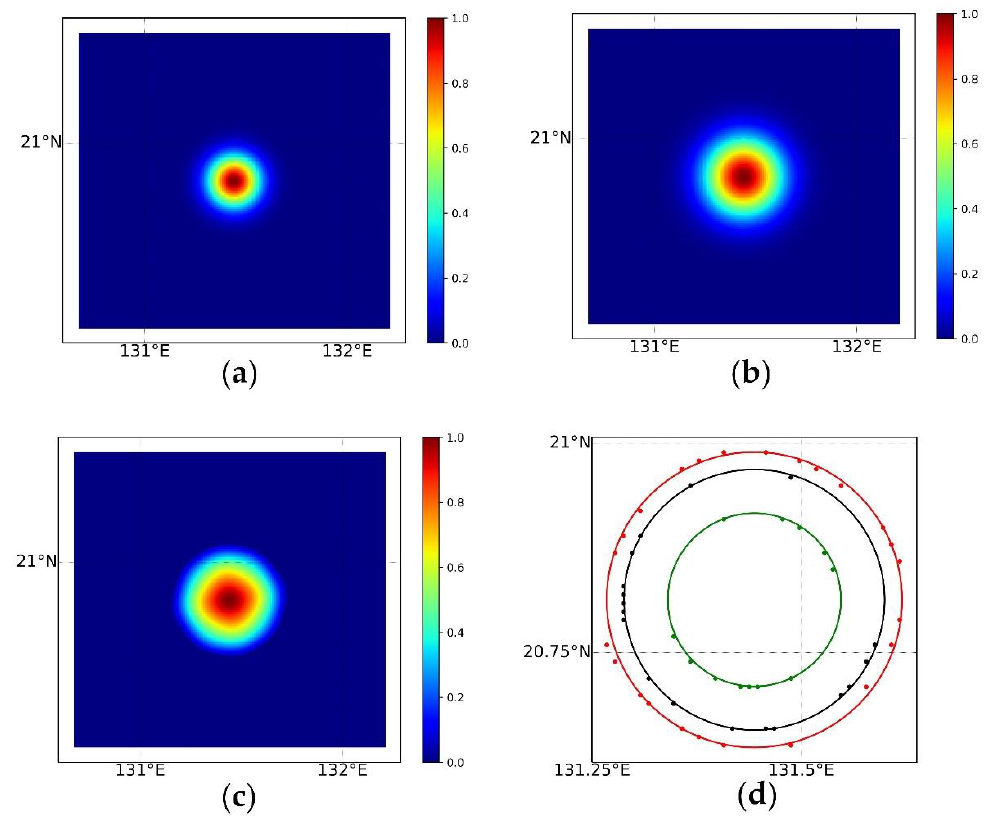
Figure 5. AGFs and half-power curves of sub-satellite point; ( a ) AGF of 2.2°; ( b ) AGF of 3.3°; ( c ) AGF resampled by BGI; ( d ) half-power points and half-power curves obtained from an AGF of 2.2° (green), an AGF of 3.3° (black), and an AGF resampled by BGI (red). Note that AGF is dimensionless.